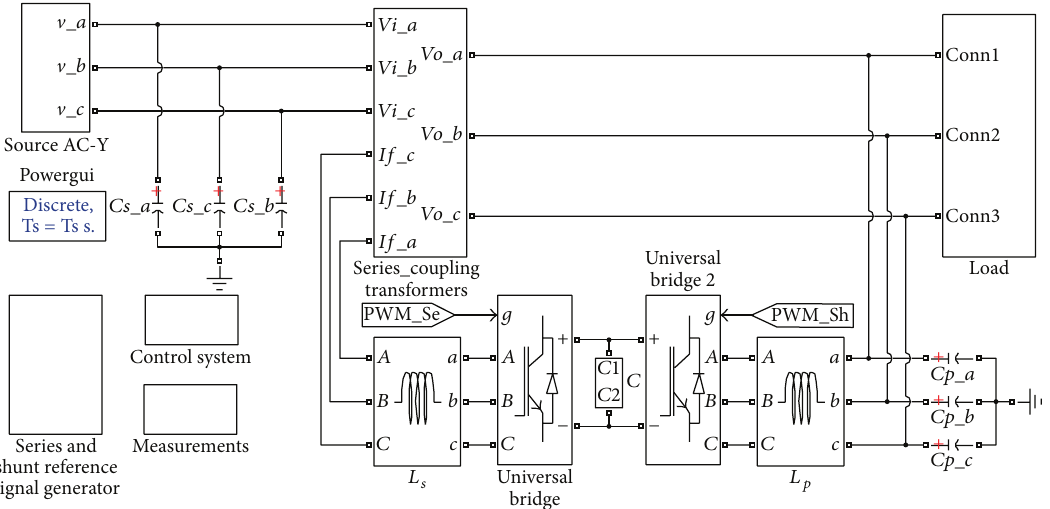
Figure 8: MATLAB-Simulink simulation algorithm.